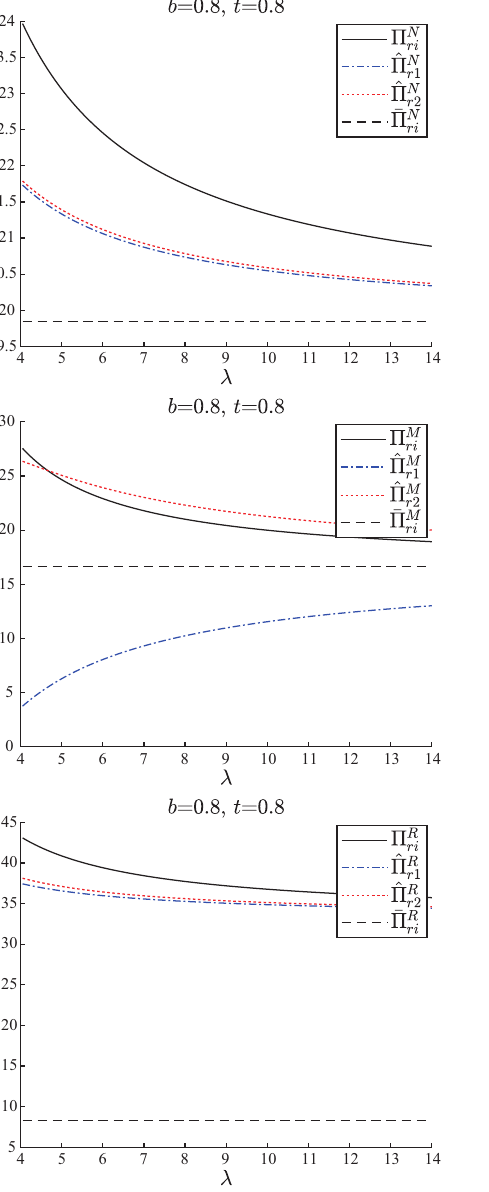
Figure 7. Profit comparison among different investment